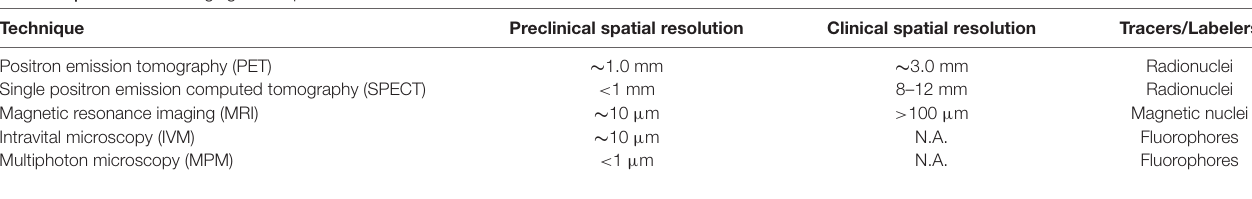
TABLE 1 | In vivo neuroimaging